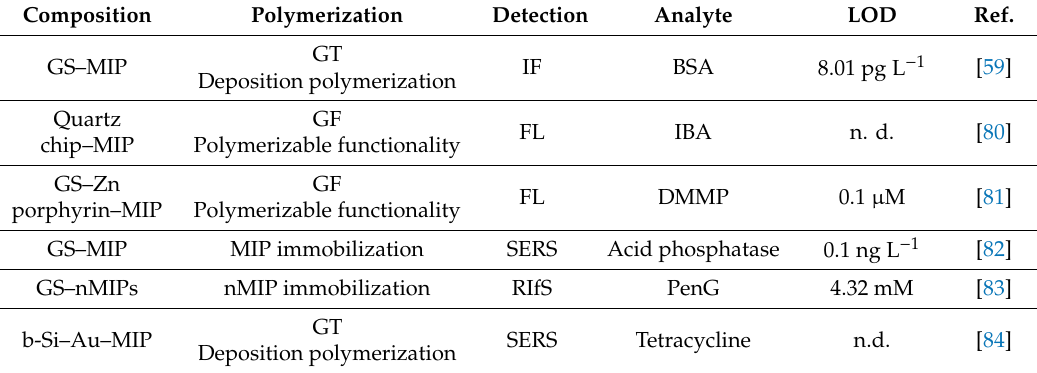
Table 2. Optical sensors based on MIPs deposited on the surface of a silicon-based slides.